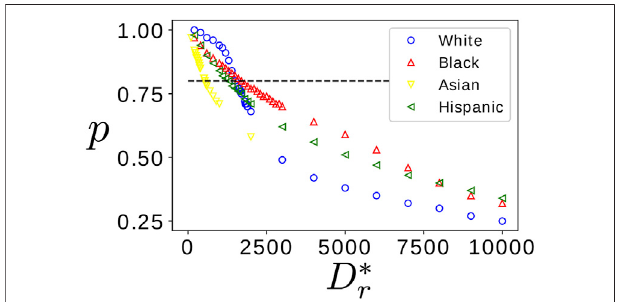
FIGURE 1 | Variation of p as a function of parameter D r ′ for each race in New York City in 2010. The Figure shows the variation of parameter p as a function of parameter D * for white, black, Asian, and Hispanic. The dashed black line corresponds to 80 % of the total population for each